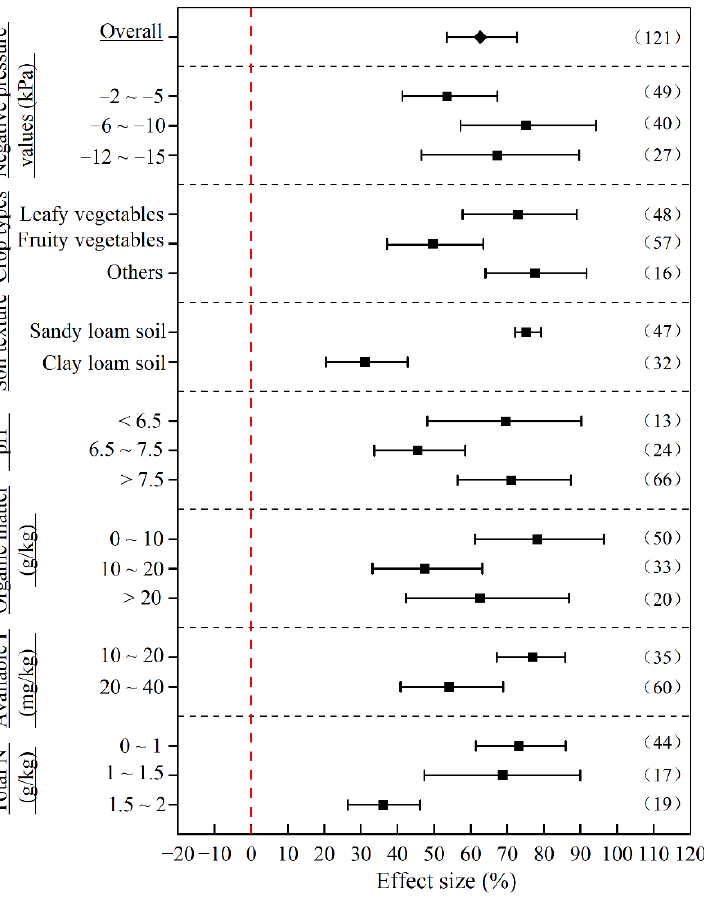
Figure 3. Effect size analysis of various factors on water use efficiencies under negative pressure irrigation compared with conventional irrigation conditions . P, phosphorus; N, nitrogen.